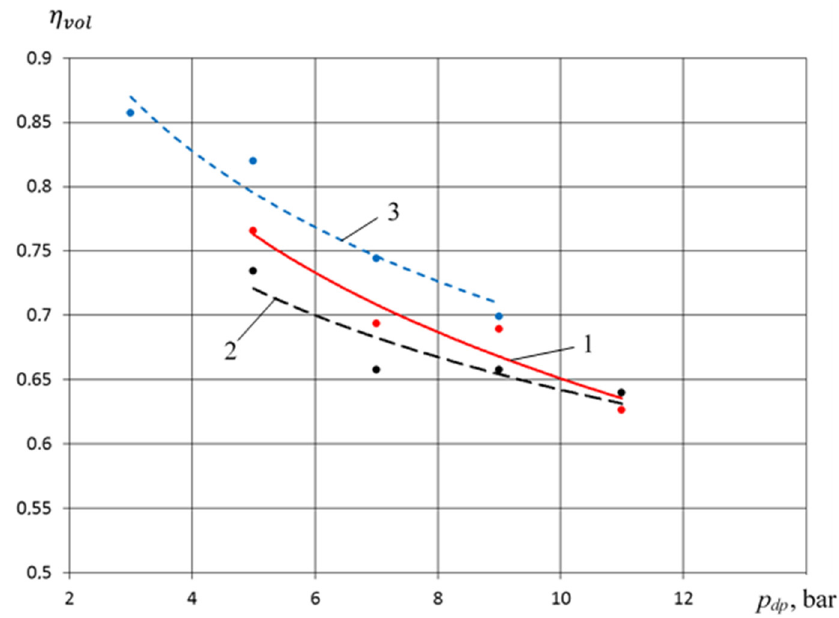
Figure 29. Dependence of volumetric efficiency of the pump section from the discharge pressure of the pump section: (1—PHPM with step-type gap seals; 2—PHPM with a smooth gap seal; 3—Crosshead-free PHPM).